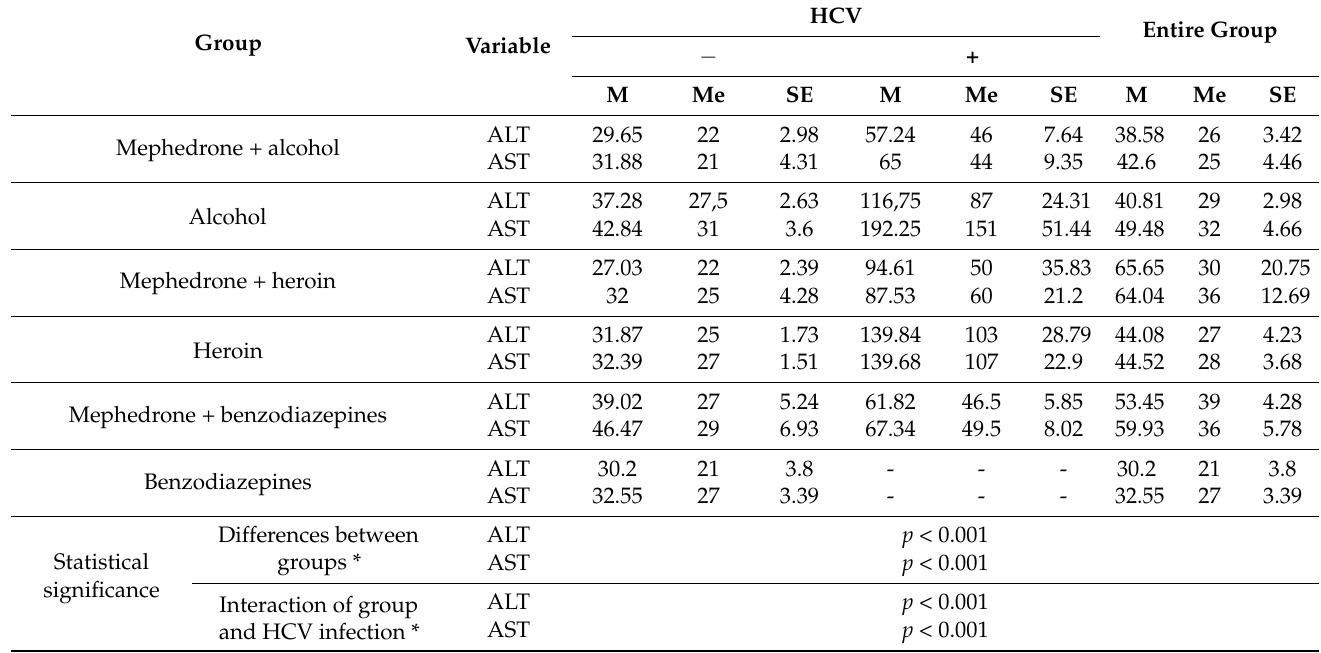
Table 3. The levels of liver enzymes in the compared groups of patients, i.e., divided according to whether they are infected or not with HCV. Group